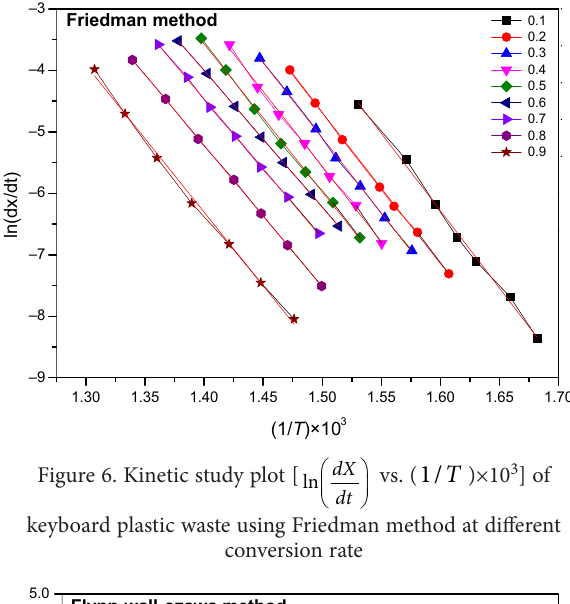
6. Kinetic study plot [ ln dX